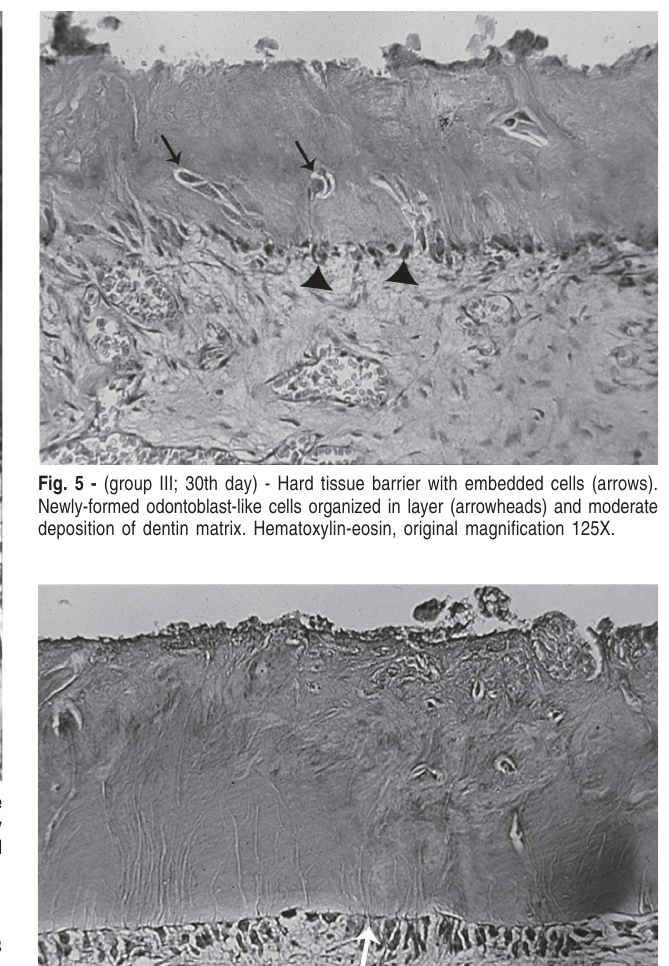
tissue exhibited normal histological characteristics (Figure 6).